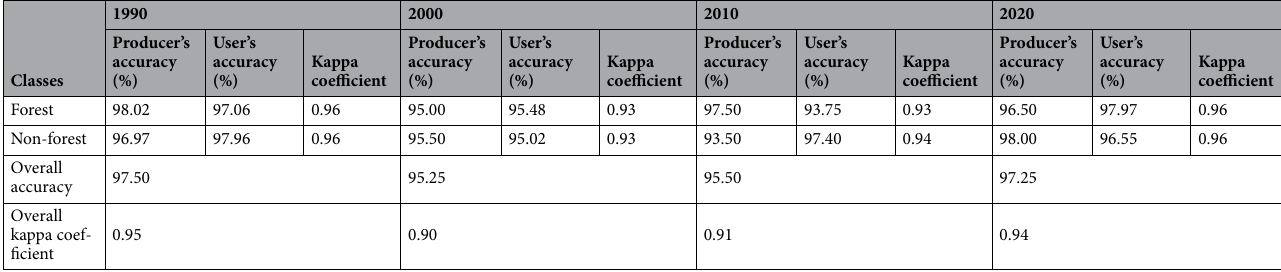
Table 3. Accuracy assessment for classified images.